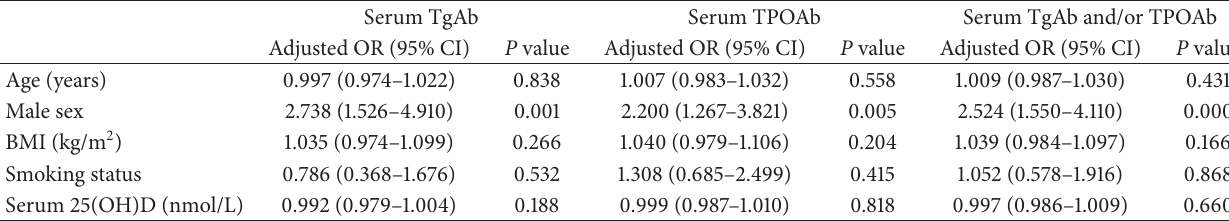
Table 3: Determinants of positive serum thyroid antibodies.